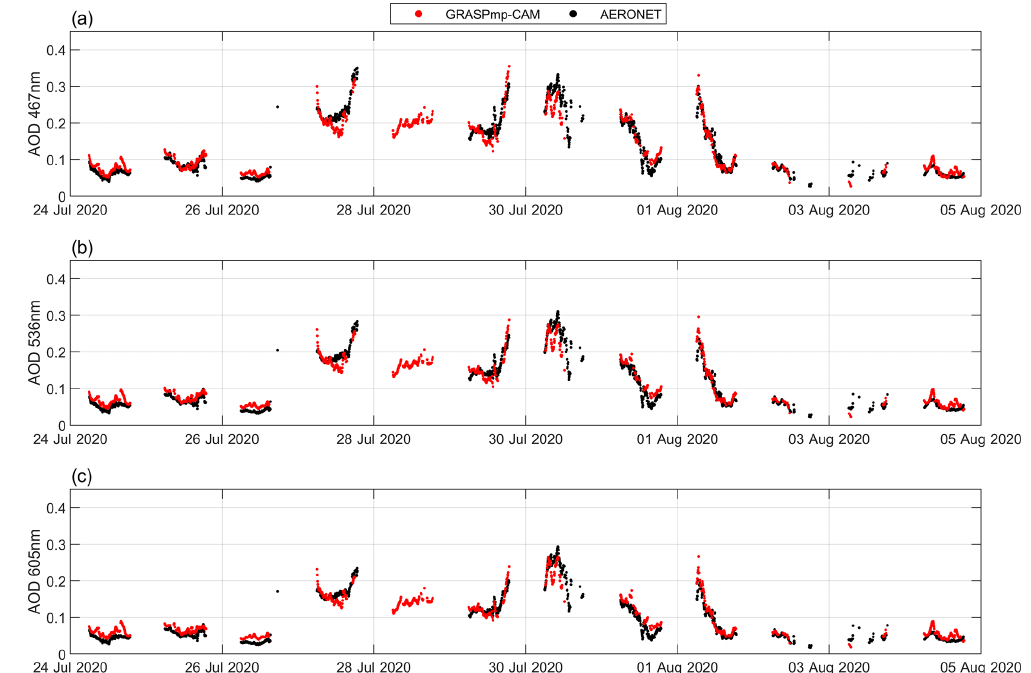
Figure 15. Aerosol optical depth (AOD) at 467nm (a) , 536nm (b) and 605nm (c) retrieved by GRASP with the multi-pixel approach (GRASPmp-CAM) and by AERONET at Valladolid from 24 July to 4 August 2020.